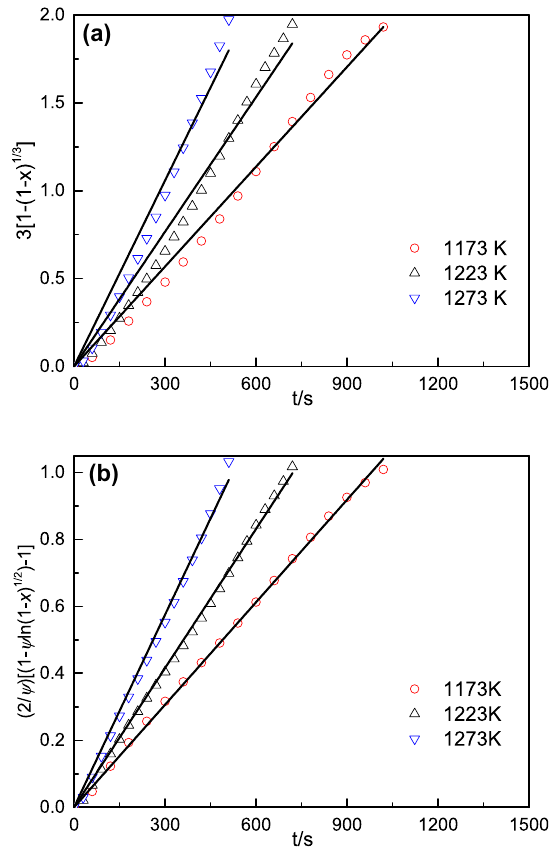
Fig. 3 Rate constant determination for the Py1073 char sample: a